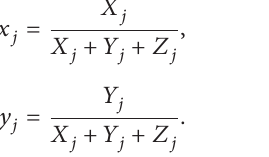
algorithm in CIE- 𝐿 ∗ 𝑎 ∗ 𝑏 ∗ color space. The evaluation of the mapping coefficient Φ RGB → sRGB and Φ RGB →𝐿 ∗ 𝑎 ∗ 𝑏 ∗ with 4